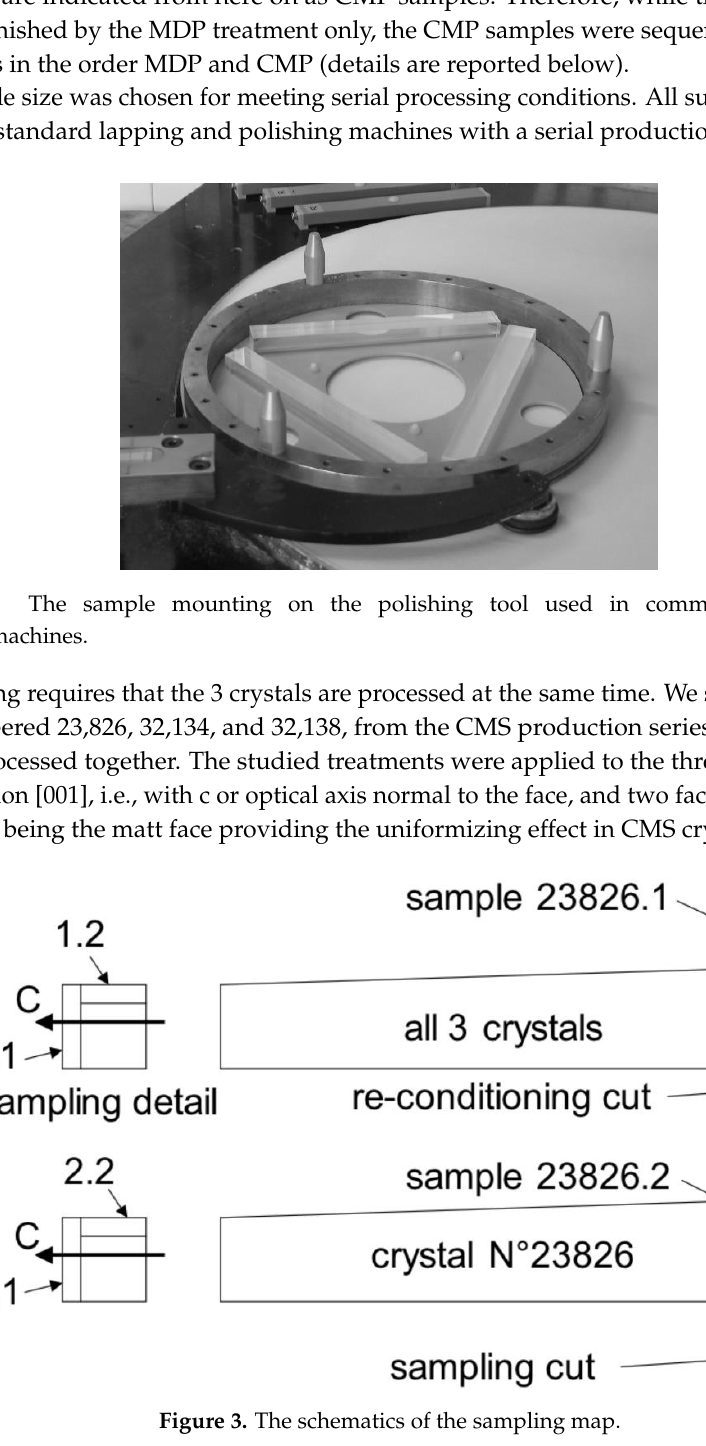
Table 1. The surface treatment parameters.